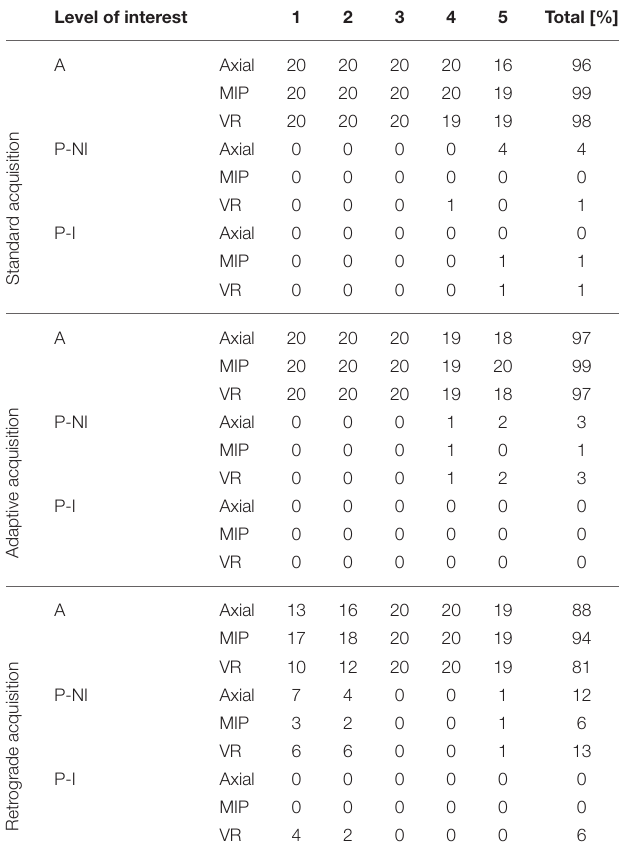
TABLE 6 | Number of segments with venous return and influence on the interpretation at each level of interest for the three different acquisition techniques. Level of